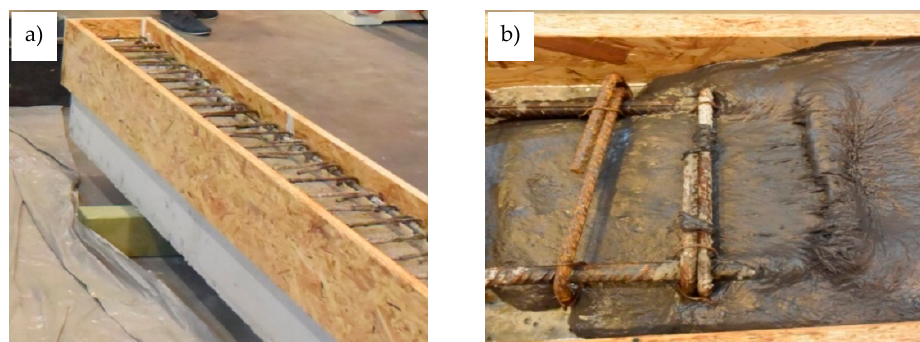
Figure 7. ( a ) Formwork for the RPC layer. ( b ) Pouring the RPC mixture.